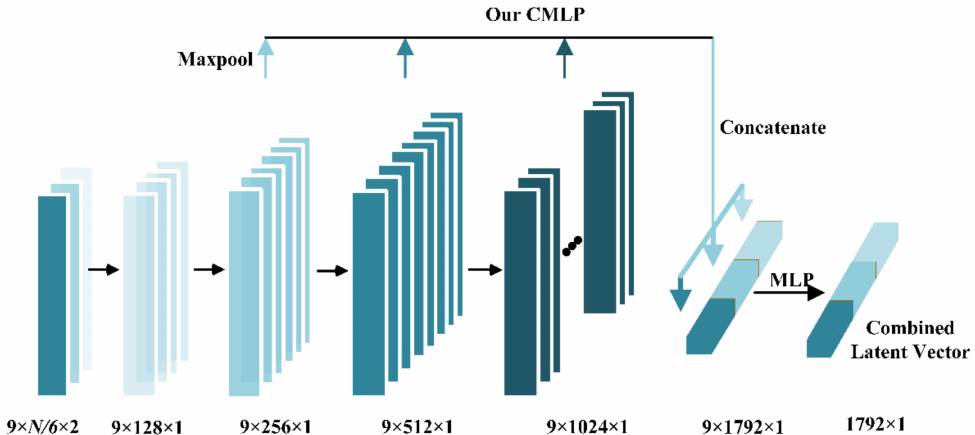
Figure 4. Structure of the proposed